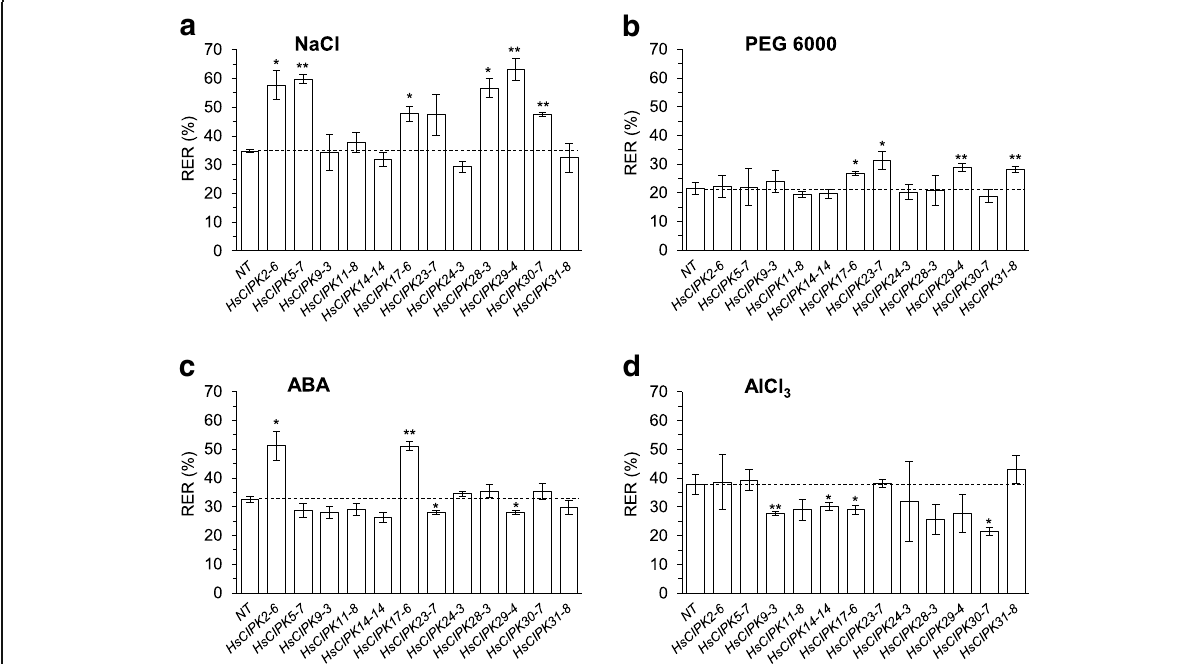
Fig. 6 Effects of salt, drought, ABA, and Al treatments on root growth in rice seedlings overexpressing HsCIPKs . a-d Root relative elongation rates (%; RER) of four-day-old rice seedlings overexpressing HsCIPKs treated for 24 h with 50 mM NaCl ( a ), 10% PEG6000 ( b ), 1 μ M ABA ( c ), and 50 μ M AlCl 3 ( d ), respectively. Values shown are means ± SD. Single and double asterisks indicate P < 0.05 and 0.01, respectively ( t test; compared to the wild-type control NT seedlings). NT, nontransgenic regeneration